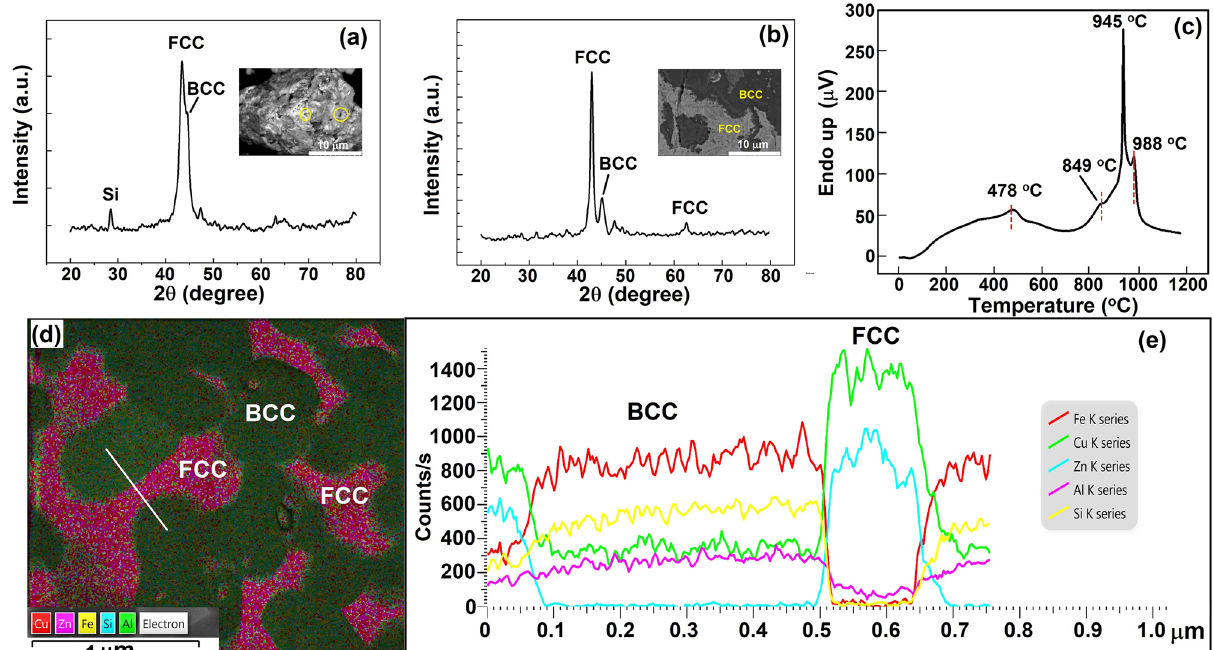
Figure 4. ( a ) XRD patterns of the filler powder after 45 h of milling and ( b ) densified filler after SPS at 650 °C. The inset shows the SEM images corresponding to each ( a , b ). ( c ) melting point of the HEAF in this